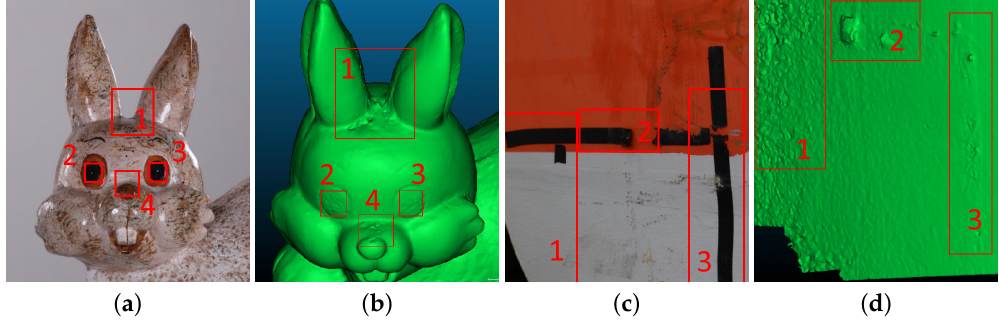
Figure 1. Illustration of Structure from Motion (SfM) reconstruction geometrical errors, which need to be distinguished from real surface roughness. Noise parts are shown in red. The problematic areas in